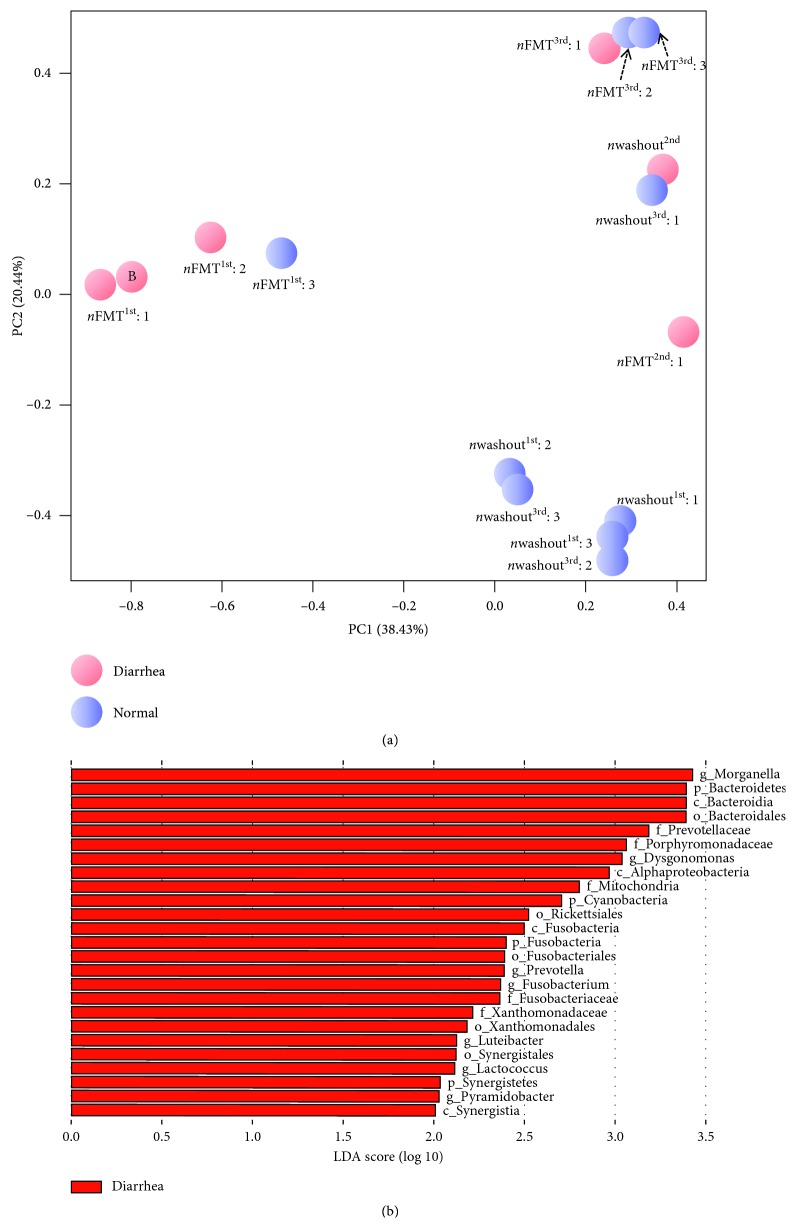
The differences in microbiota species between diarrhea and nondiarrhea stages. (a) Principal coordinates analysis of microbiota species composition of all samples during the whole study. Principal coordinate 1 (PC1, x-axis) explains 38.43% of the variance, and principal coordinate 2 (PC2, y-axis) explains 20.44% of the variation in Bray–Curtis dissimilarity between samples grouped by diarrhea status (pink circle = diarrhea, blue circle = normal). (b) LDA coupled with effect size measurements identifies the most differentially abundant taxa between diarrhea and normal status. Diarrhea-enriched taxa are indicated with a positive LDA score (red). No obvious differentially abundant taxa were observed in samples with normal status (not shown). Only taxa meeting an LDA significance threshold of >2 are shown.